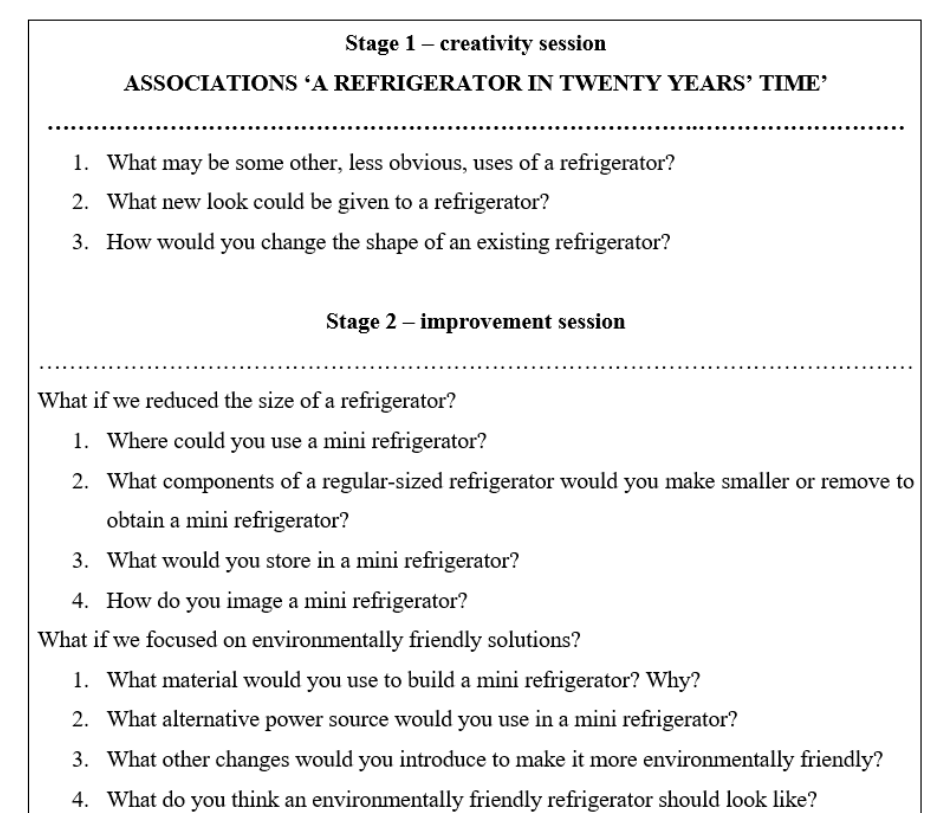
Figure 2. Questions asked to participants of the eco-innovation session.